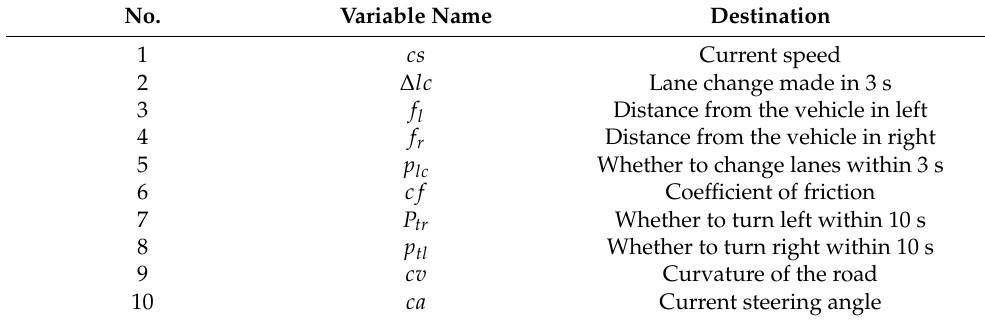
Table 5. Input data set of the